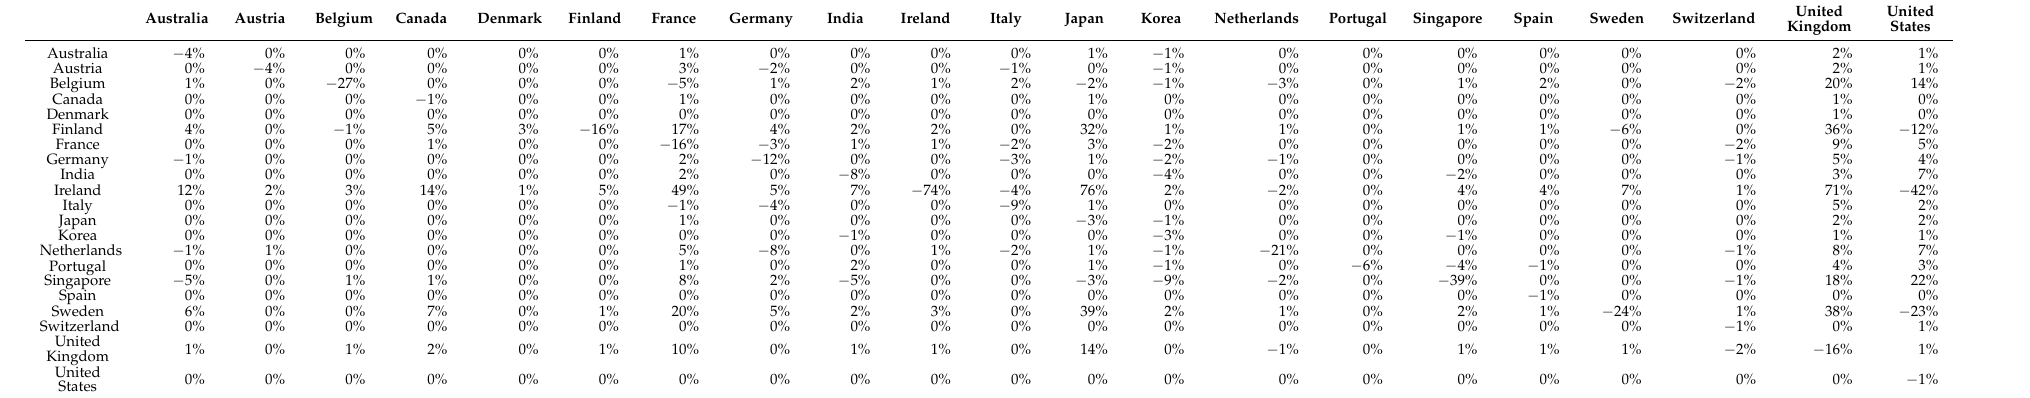
Table 4. Variation in countries’ systemic risk contributions when the column header country is isolated (%).